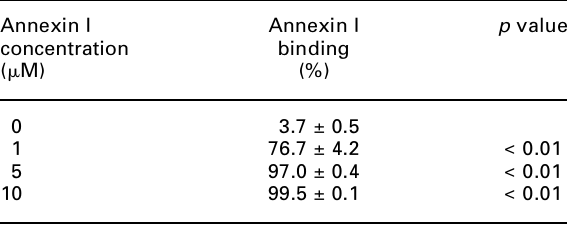
Table 1. Annexin I binding sites on human